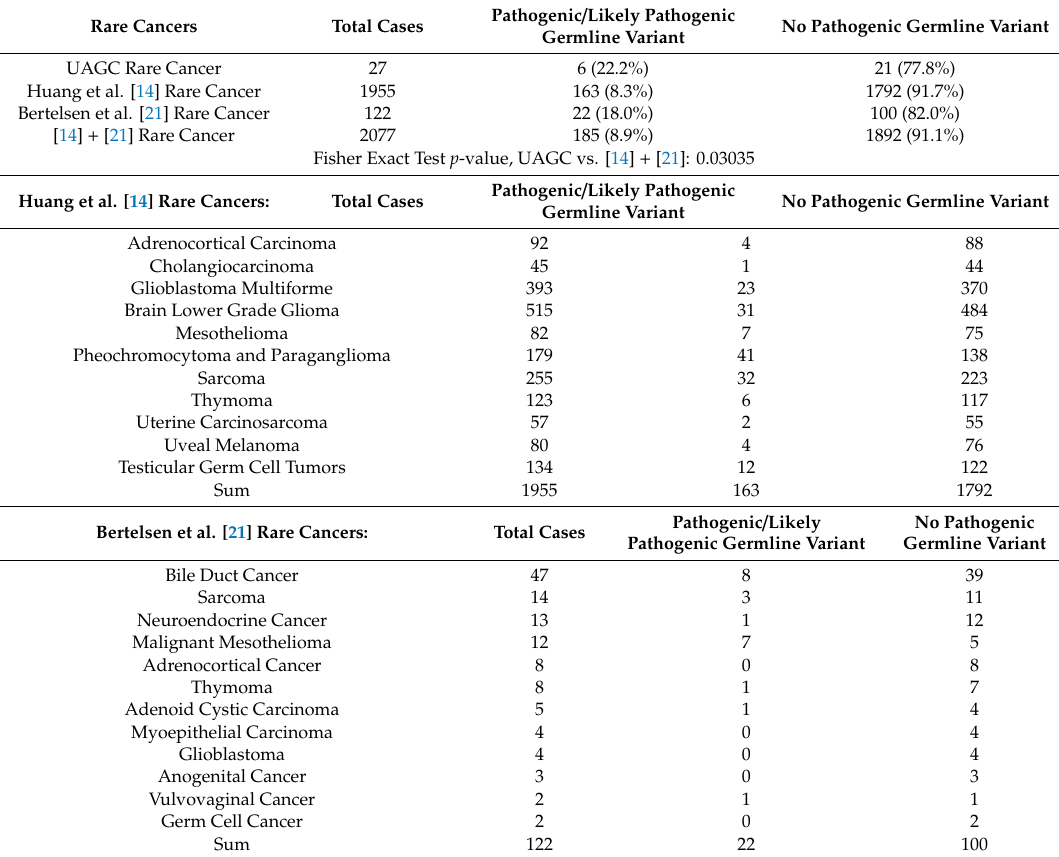
Table 4. Pathogenic / Likely Pathogenic Germline Variants detected across